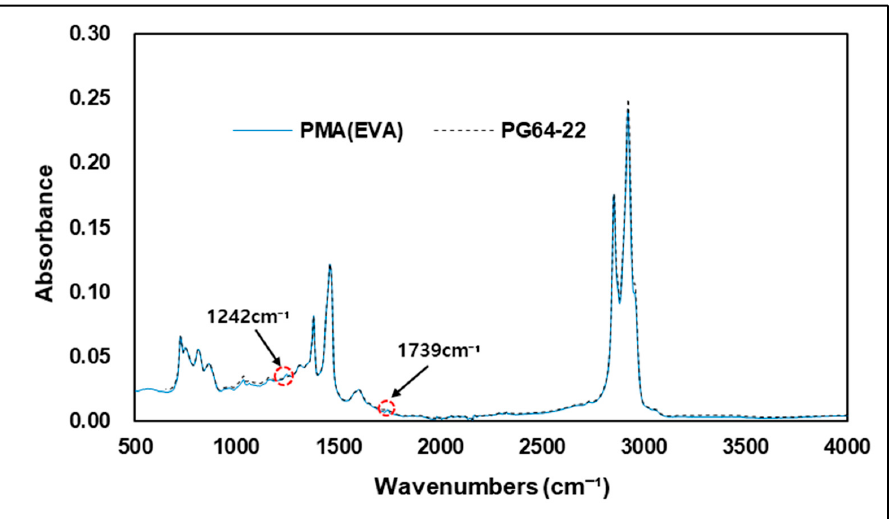
Figure 12. FTIR spectrum of PMA (EVA) and PG 64-22.